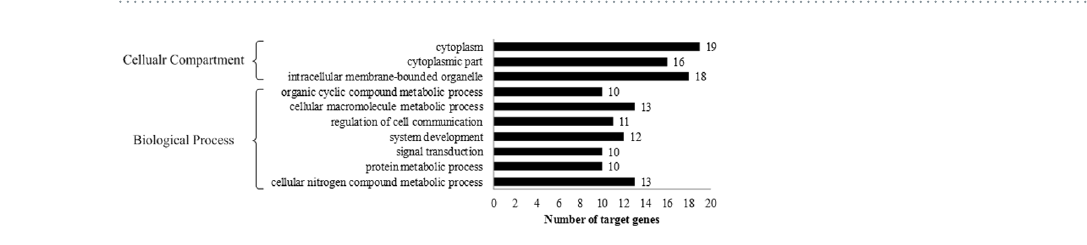
Figure 6. Expression of marker miRNAs measured by RT-qPCR. 1: Aca-miR-155-5p; 2: Bta-miR-132; 3: Mmu- miR-155-5p; 4: Aca-miR-212a-5p; 5: Dre-miR-205-3p; 6: Tgu-miR-155-5p; 7: oan-miR-147. Due to the different relative expression levels, the marker miRNAs were divided into two graphs with higher average ΔΔ CT value ( A ) and lower average ΔΔ CT value ( B ), respectively.